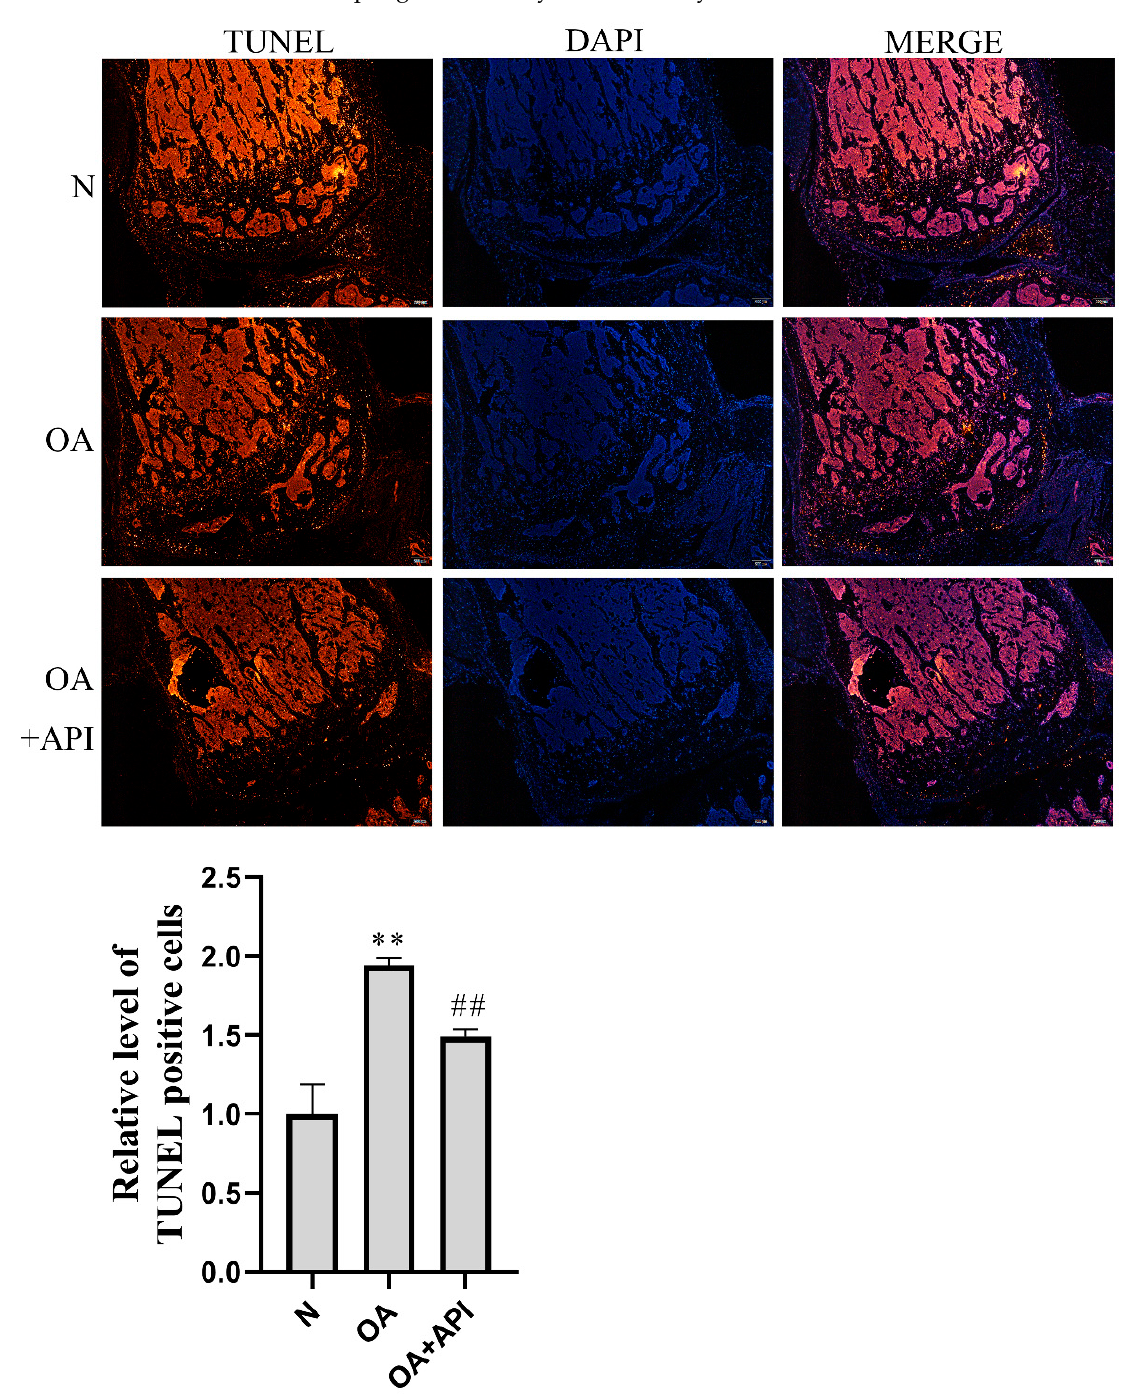
Figure 2. Apigenin reduced chondrocyte apoptosis in OA mice. Above are representative pho- tographs of TUNEL staining in articular cartilage sections (magnification, × 40), The blue fluorescence is DAPI and the red fluorescence is TUNEL. Compared with the N group, the OA group showed a significant increase in TUNEL-positive cells, and the apoptosis of cells was increased. Apigenin, however, reduced apoptosis. The figure below shows the quantified fluorescence intensity of TUNEL-positive cells: ** p < 0.01 versus normal group (N); ## p < 0.01 versus OA group. The reverse transcription (RT)-PCR results showed that the levels of IL-1 ( p < 0.01), IL-6 ( p < 0.05), MMP3 ( p < 0.05), and MMP13 ( p < 0.05) were markedly elevated in the